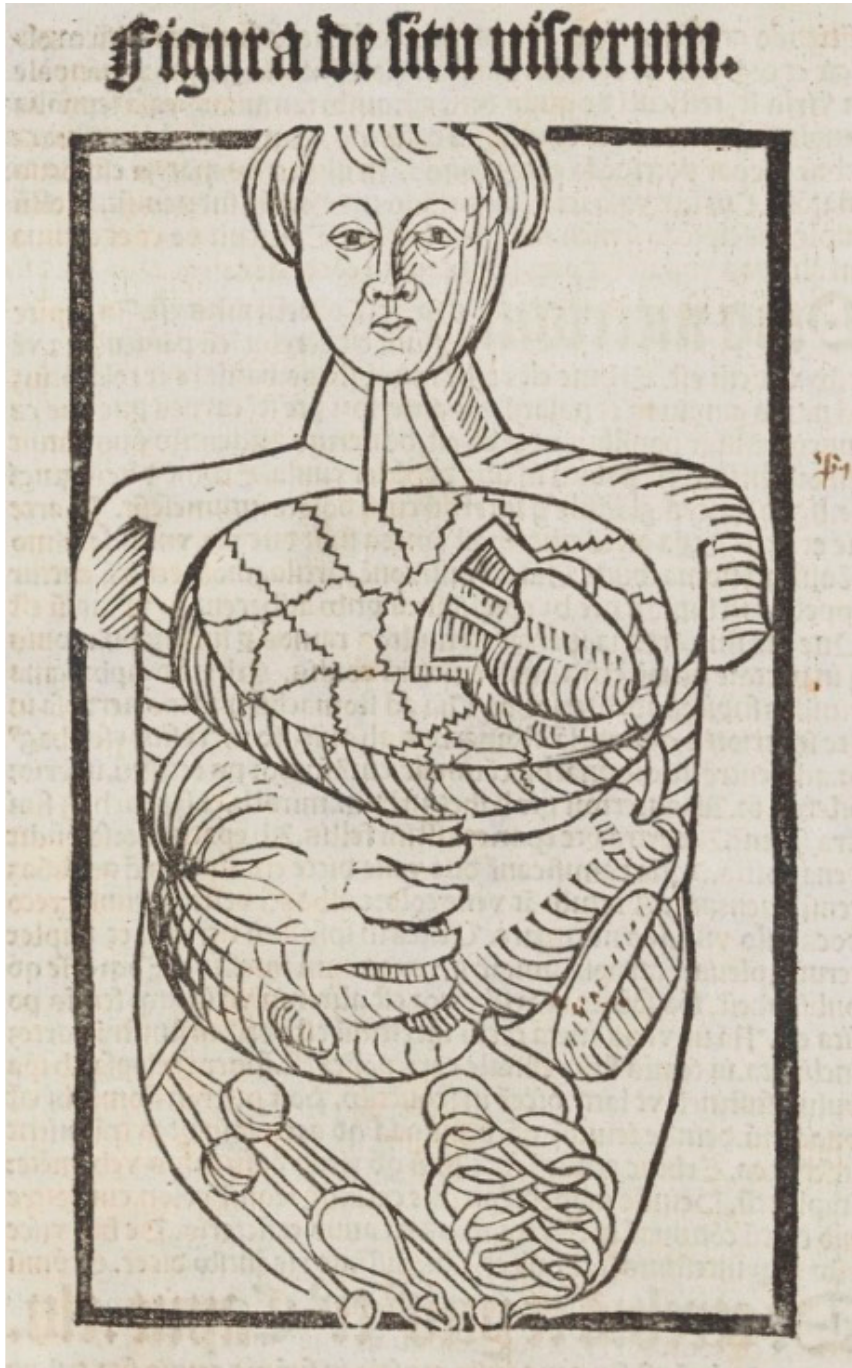
Figure 2. Hundt’s illustration of the location of the viscera (Hundt 1501, fol. L IIr).